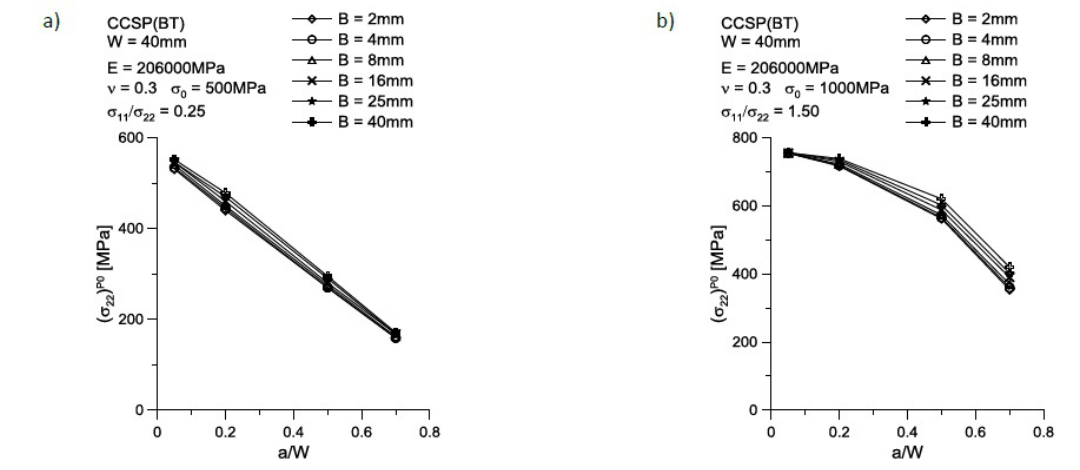
Figure 17: Limit load ( σ 22 ) P 0 against relative crack length for three-dimensional cases at fixed ratio and yield